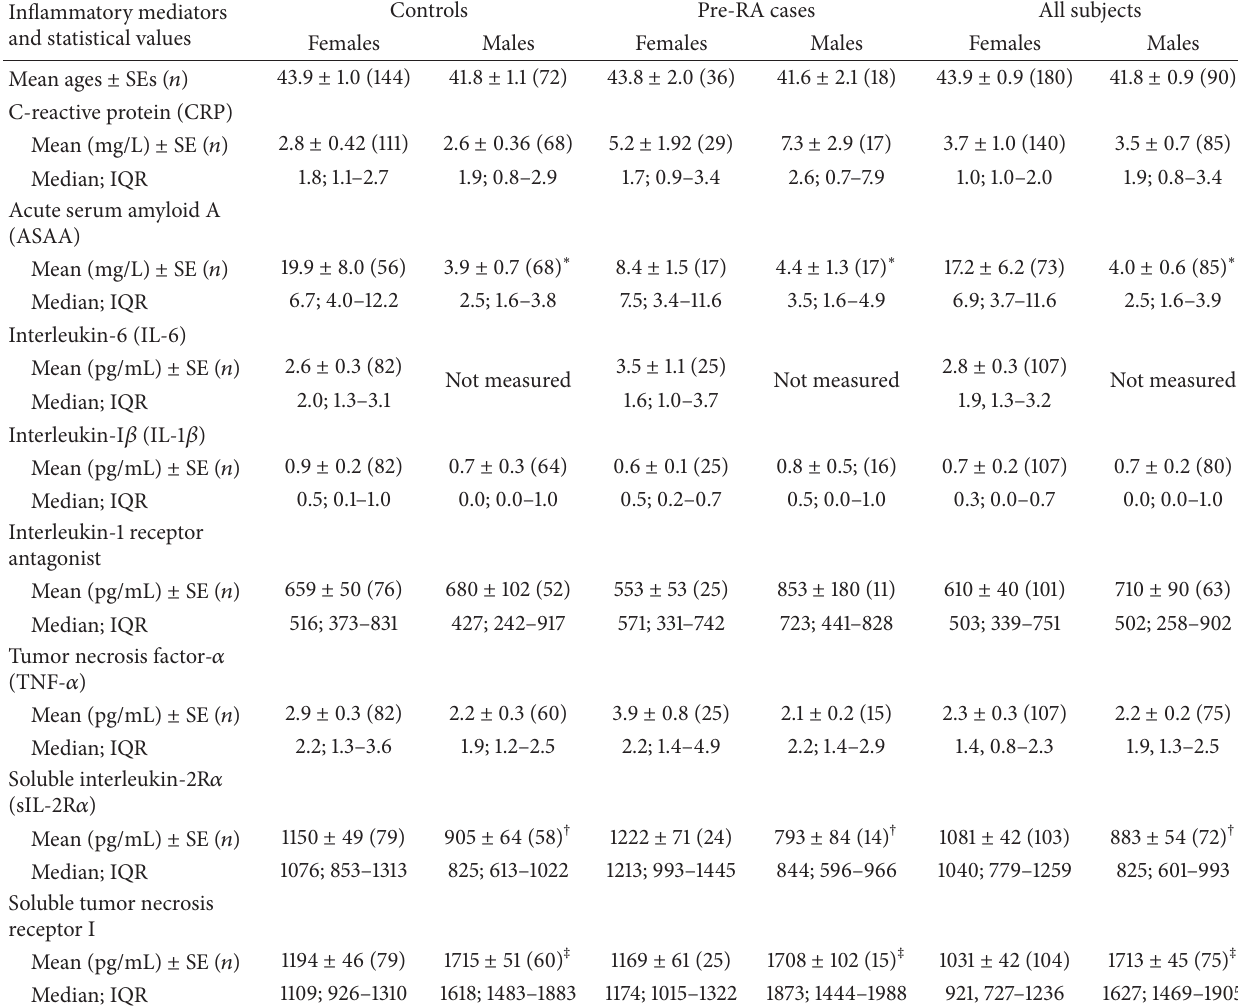
Table 1: Reported values of inflammatory biomarkers assayed by reference